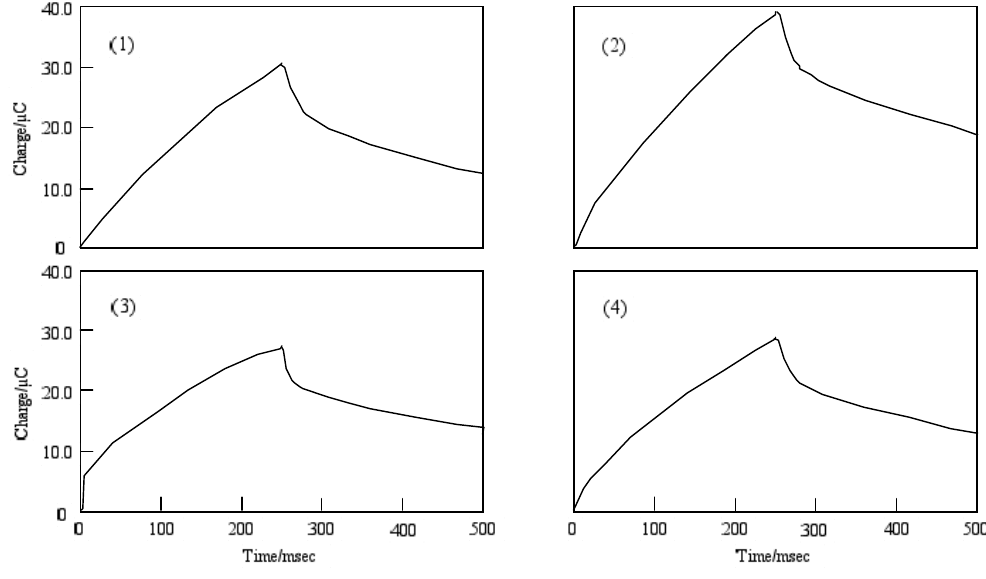
Figure 9. Chronocoulometry of cobalt phthalocyanine tetrasulfonic acid. Potential step; − 1.2–1.6 V vs. Ag/AgCl, time interval: 250 ms. (1) Cobalt phthalocyanine tetrasulfonic acid. (2)